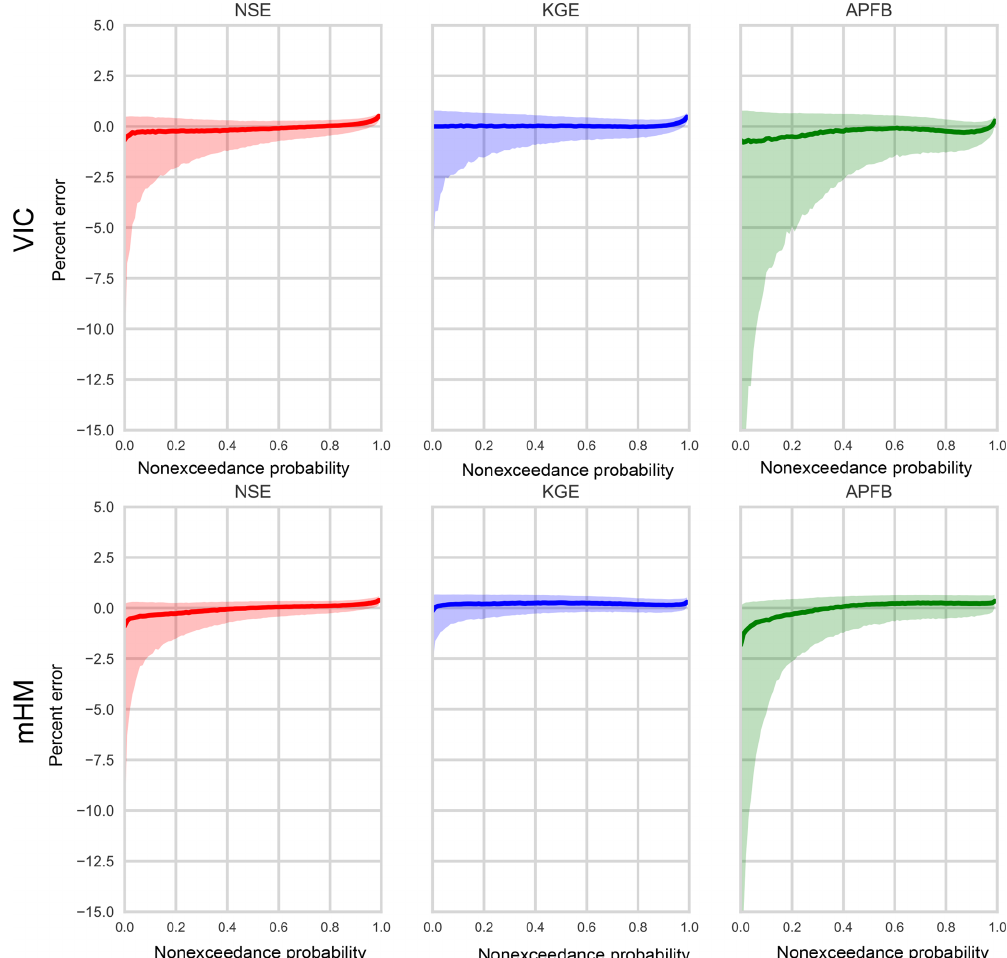
Figure 7. Residual distributions conditioned on the non-exceedance probability of the daily flows over the 492 study basins. Analyses are presented for the three calibration performance metrics. Daily residuals are computed based on the observed and simulated flows during the evaluation